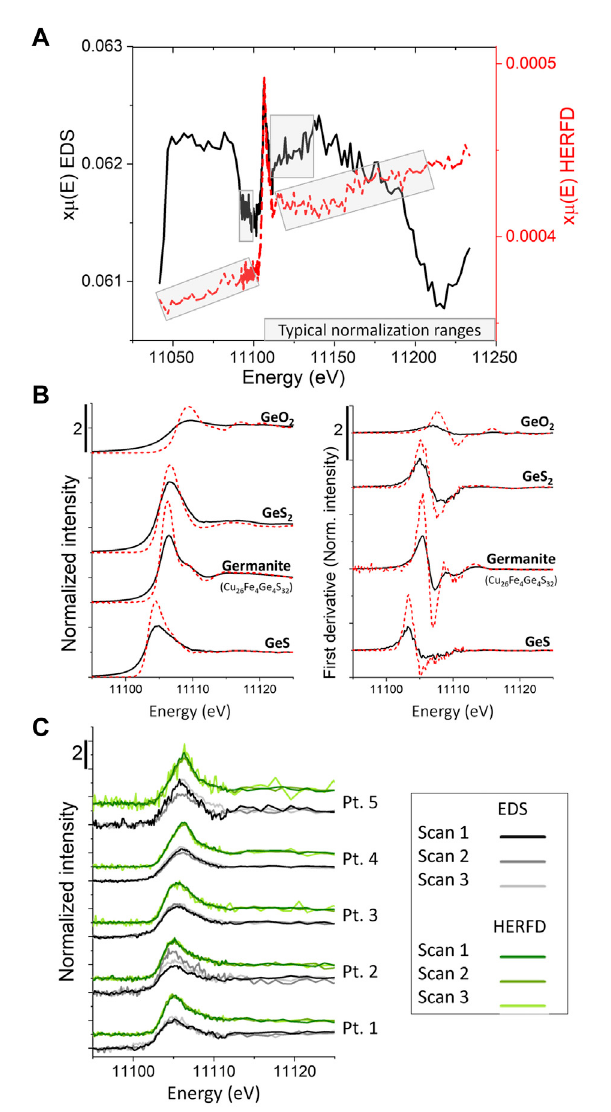
FIGURE 9 Comparison of HERFD and EDS Ge μ -XANES spectra. (A) Typical raw sphalerite spectra from HERFD (red line) and EDS (black line) detectorscollectedsimultaneously.Note,HERFDhaslowerbackground and a more linear pre- and post-edge, enabling easier normalization; (B) Normalized reference spectra and fi rst derivative of normalized spectra, demonstrating the higher spectral resolution of the HERFD data; (C) Comparison of individual scans from HERFD and EDS detectors from the transect shown in Figure 3. Note that the S:N ratio in most scans is better for the HERFD data, but both detectors intermittently exhibit unusually low S:N, even when the other detector scan appears